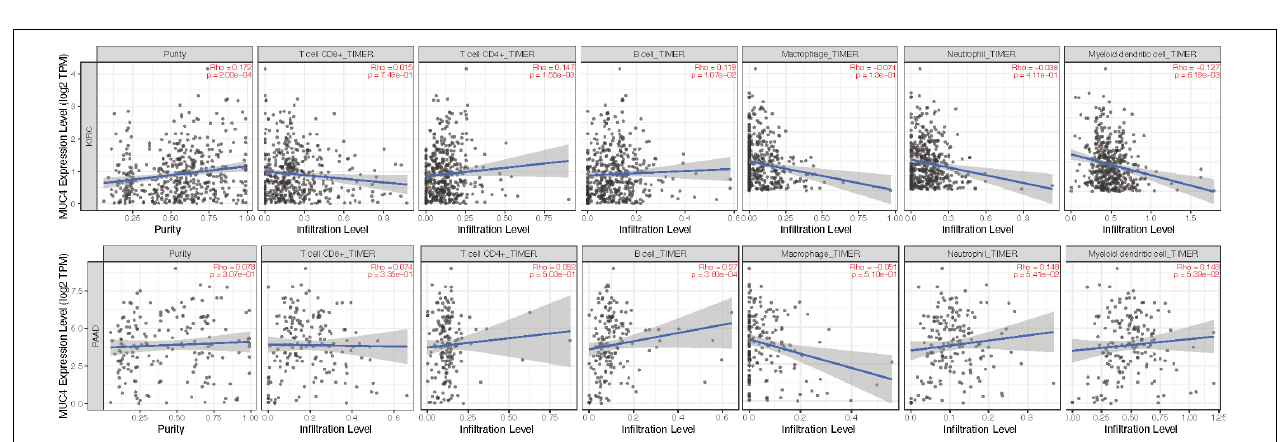
FIGURE 5 | Coefficients for correlation between MUC4 and immune cell infiltration of KIRC and PAAD in TIMER2.0.